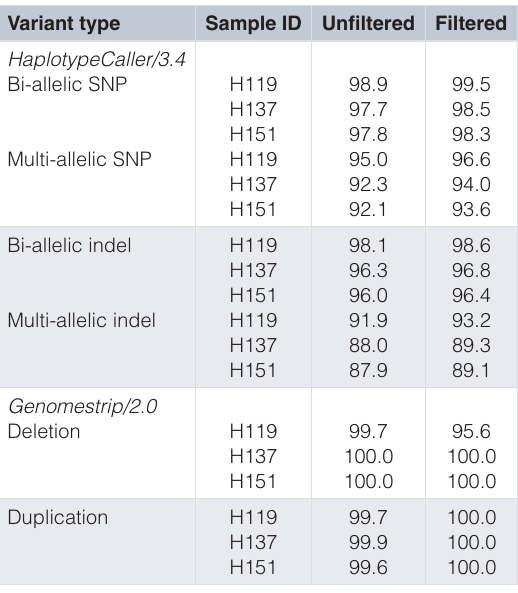
Table 3. Genotype reproducibility